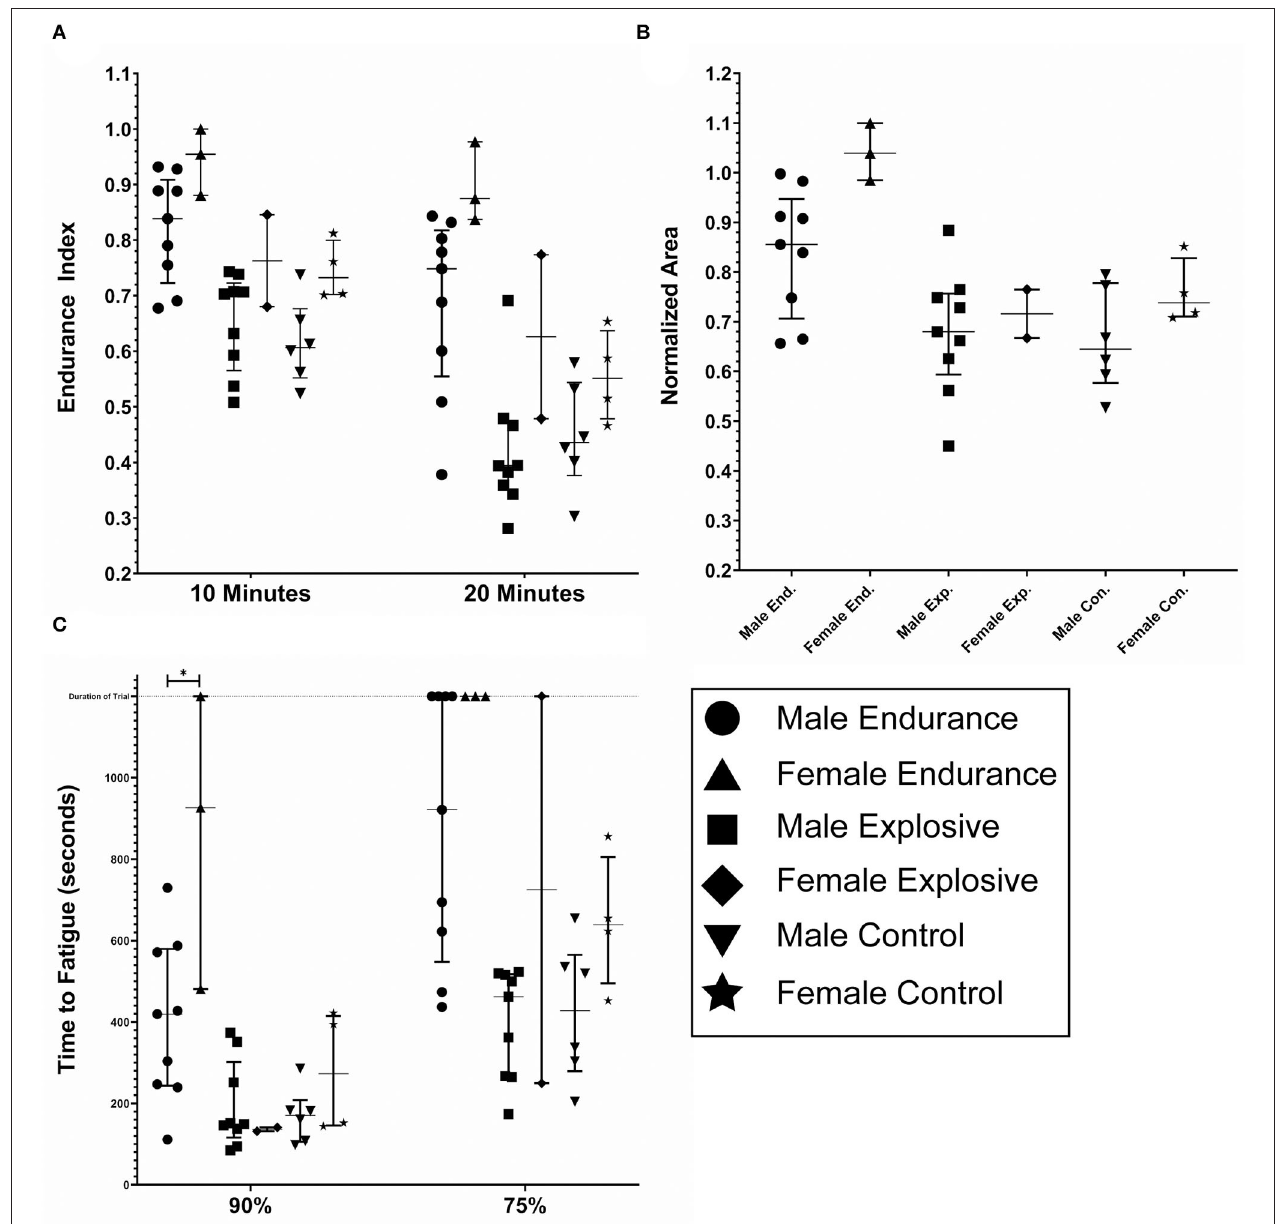
FIGURE 6 | Fatigue metrics by gender; male endurance ( n = 9), female endurance ( n = 3), male explosive ( n = 9), female explosive ( n = 2), male control ( n = 6), and female controls ( n = 4). (A) The endurance index as measured at the 10 and 20min timestamp. (B) The normalized area. Some subjects had calculated values